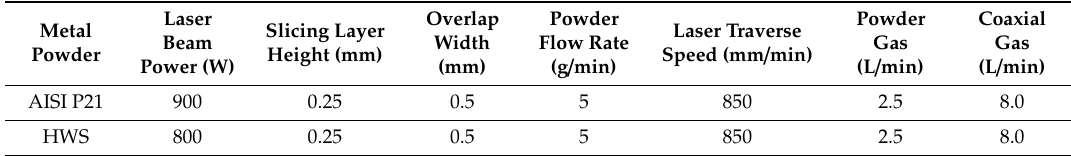
Table 3. Process parameters for additive